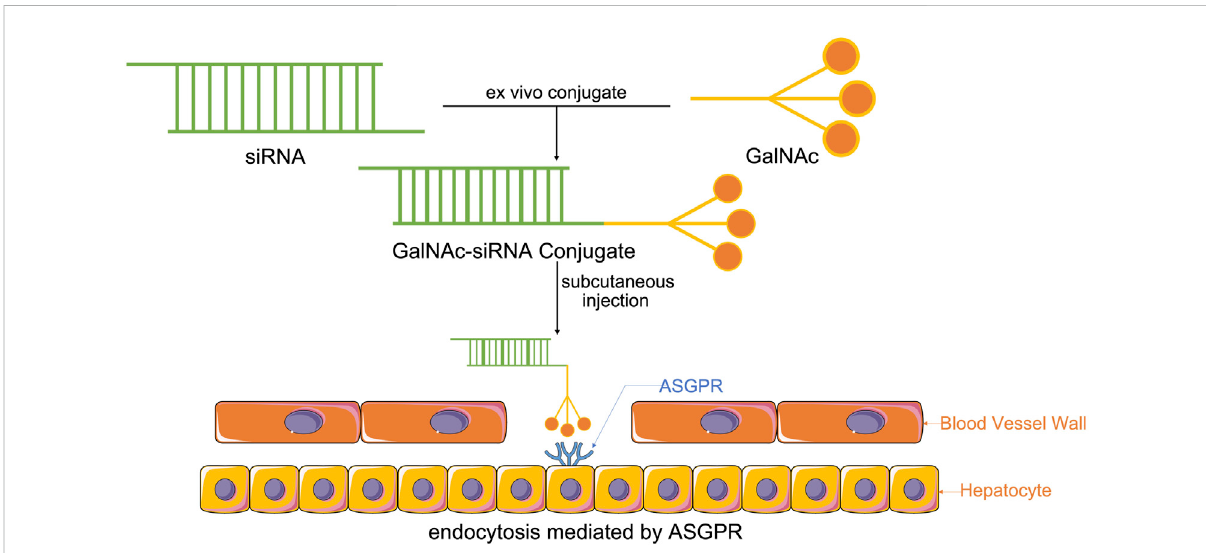
Synthesis of GalNAc-siRNA conjugates. Through chemically synthesized conjugates, modi fi ed siRNAs with GalNAc enter the system by subcutaneous injection, which is the most effective way to help GalNAc-siRNA conjugates attach to ASGPR, the receptor, that is, chie fl y expressed on the surface of liver parenchyma cells in the hepatic sinusoid space, thus enabling ASGPR-mediated cellular endocytosis to cause siRNA to enter the cell and perform its function.